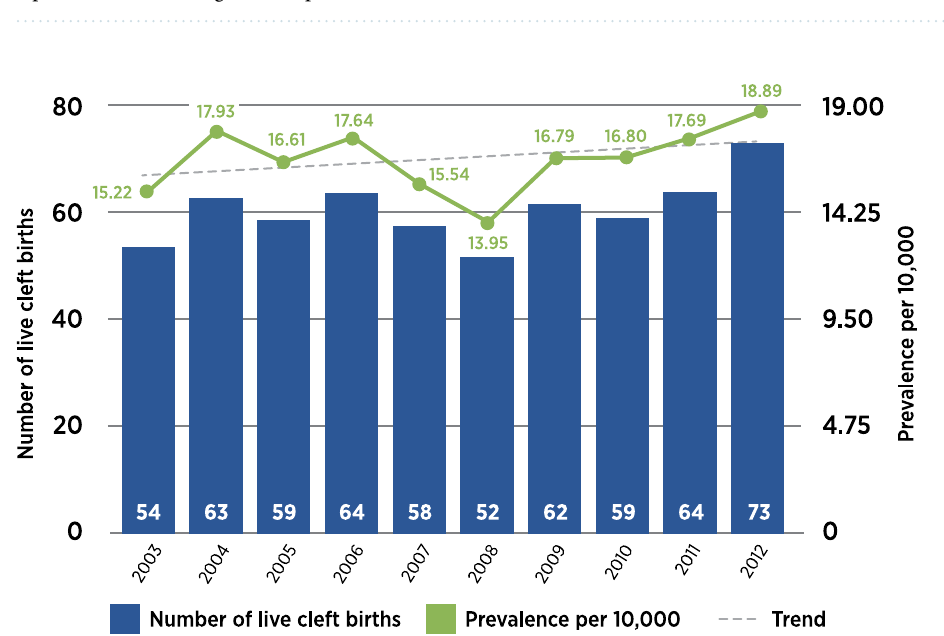
Figure 2. Prevalence of population-based live cleft births by year. Overall prevalence is 16.72 per 10,000. Upward trend is not significant (p =